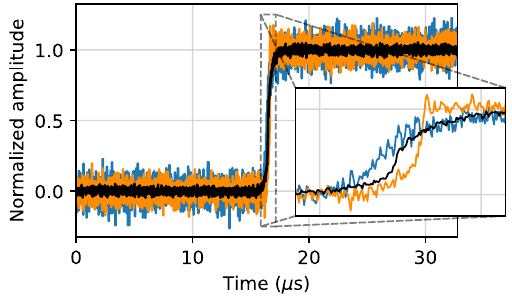
Fig. 2 Three example pulses from a germanium detector, each with a substantially different rise time. All pulses are preprocessed such that they have a baseline of zero and an amplitude of one. The black pulse has apparently less noise because it was originally a higher amplitude pulse, so that the electronic noise is smaller relative to its